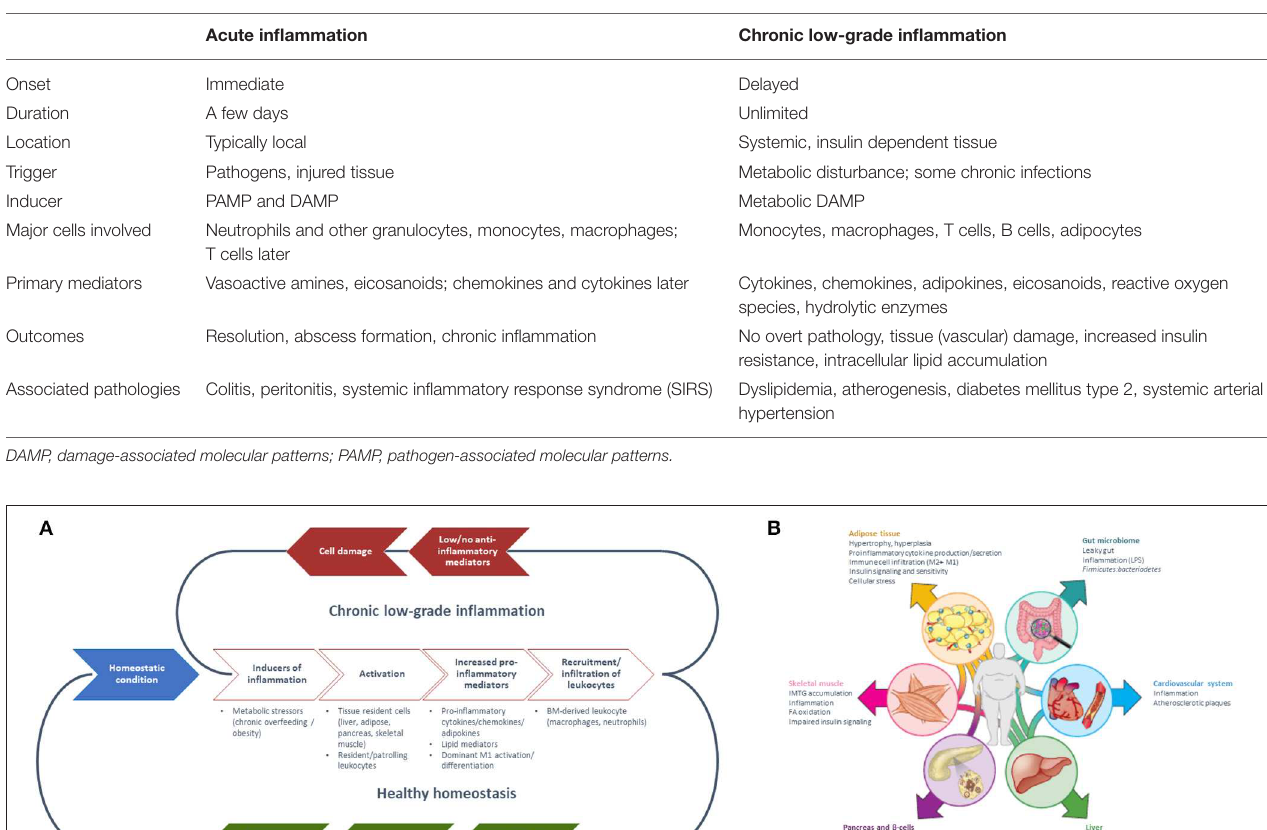
TABLE 1 | Features of acute and chronic low-grade inflammation [adapted from Calder et al. (9)].